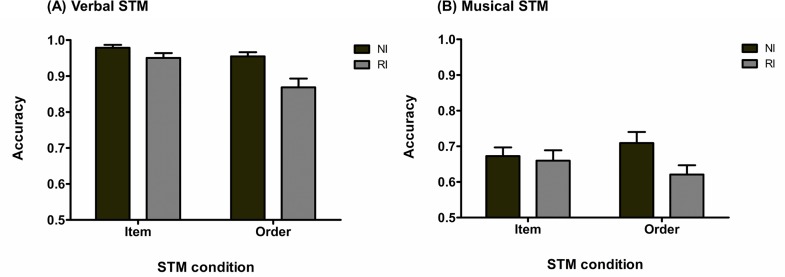
Response accuracies for Experiment 2.(A) Response accuracy (mean and standard error) for the vSTM task as a function of STM task and interference conditions (NI: no-interference; RI: rhythmic interference). (B) Response accuracy (mean and standard error) for the mSTM task as a function of STM task and interference conditions (NI: no-interference; RI: rhythmic interference).